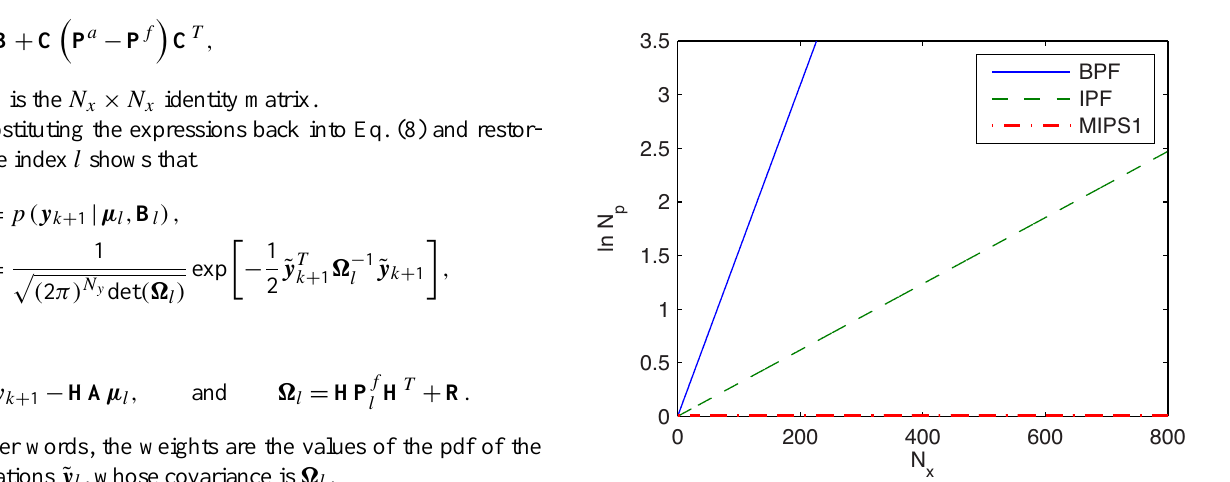
Fig. 2. Theoretical lines such that E [ 1 / max i w (i) ] = 1 / 0 . 9 for the (solid) bootstrap particle filter, (dashed) implicit particle filter and (dot-dashed) mixture-based implicit smoother with N m = 1. The dot-dashed curve is identically zero. Similar to Fig. 3 of Snyder (2012) with a corrected y axis